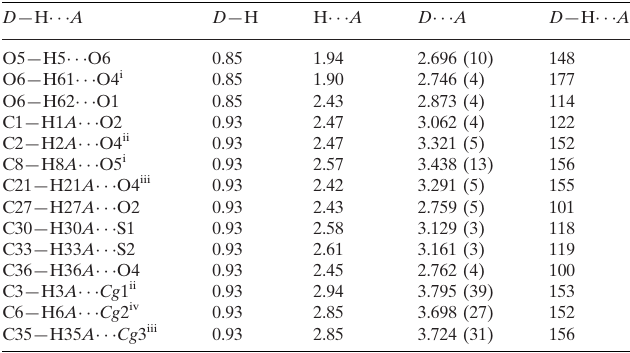
470 parameters H-atom parameters constrained Hydrogen-bond geometry (A˚ , (cid:3)